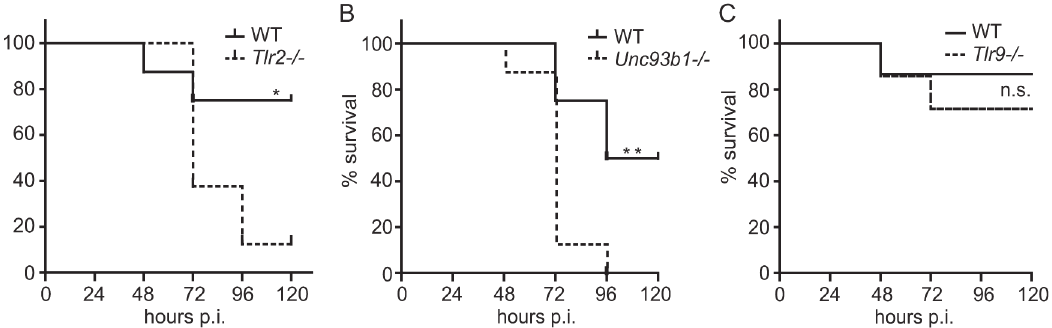
Fig 3. Entire activation of the immune responses through both Tlr2- and Unc93b1-dependent pathways is required for protective defense against S . pyogenes in mice. ( A — C ) Kaplan-Meier survival curves of C57BL/6 and Tlr2 − / − , Unc93b1 − / − (8 mice per genotype) or Tlr9 − / − mice (14 mice per genotype) after subcutaneous infection with 1×10 8 CFU of S . pyogenes ISS3348 . Survival was monitored for 6 days. Significance: * = p < 0.05; ** = p <